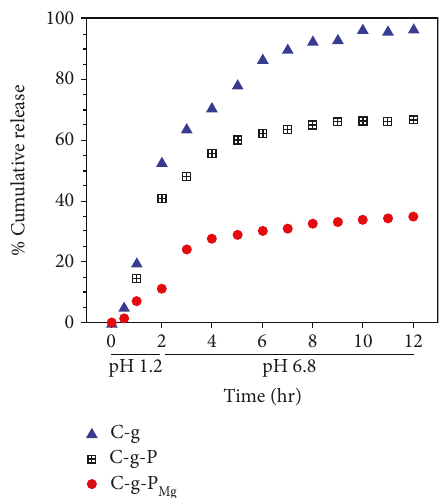
Figure 7: Cumulative release (%) of curcumin for C-g ( fi lled triangle), C-g-P (crossed square), and C-g-P absence of